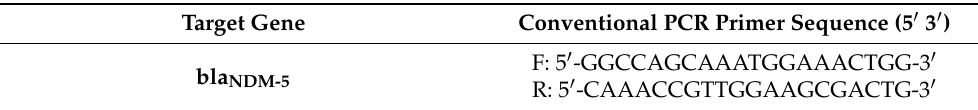
Table 2. PCR primer for NDM-5 used for detecting the presence of clinical isolate 1176 in urine samples in conventional PCR. F: Forward and R: